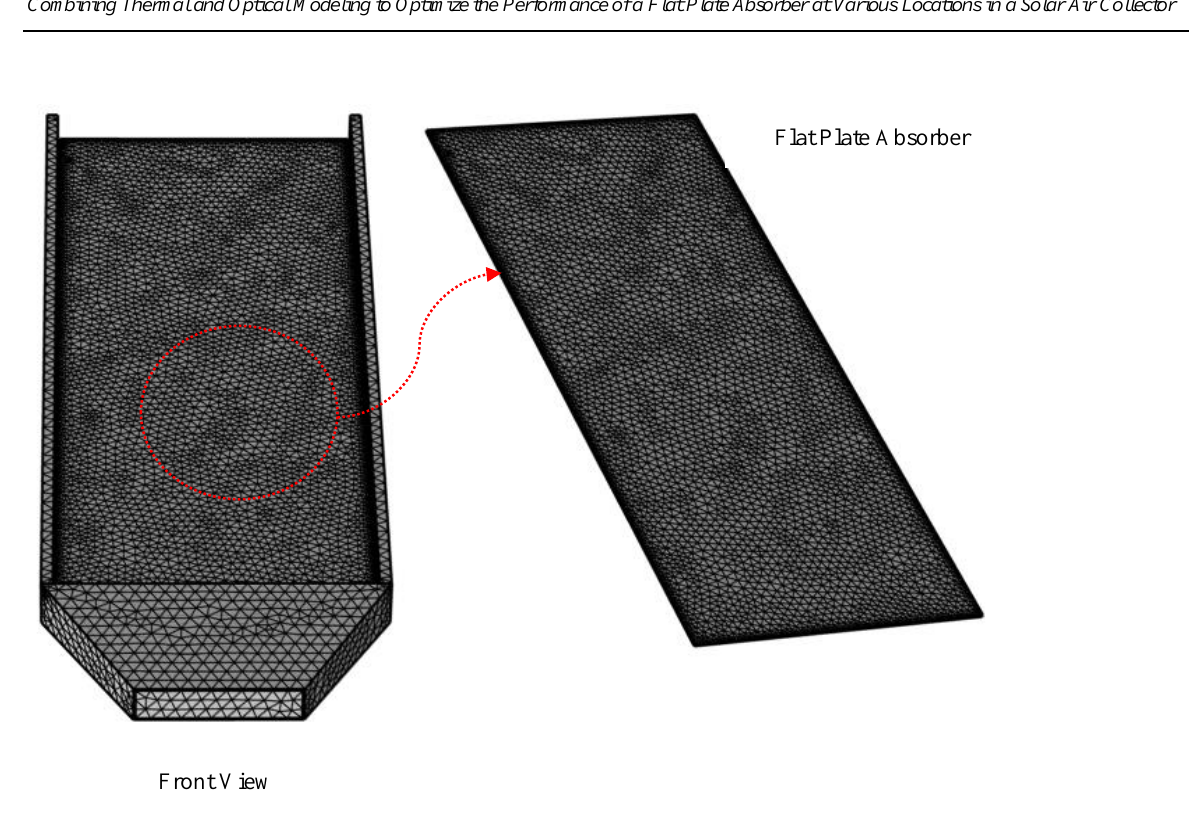
Figure 3. The meshes generated for the CFD simulation of solar collectors